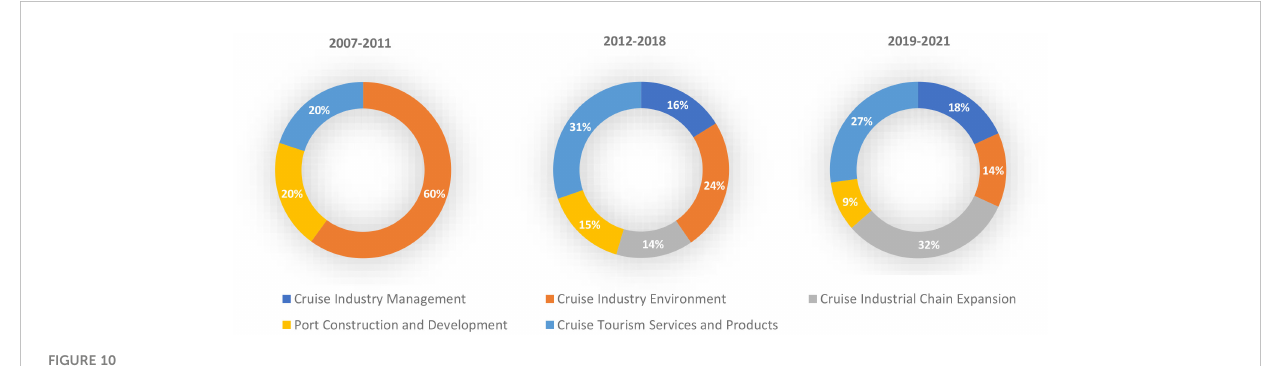
FIGURE 10 The theme distribution of cruise policies from 2007 to